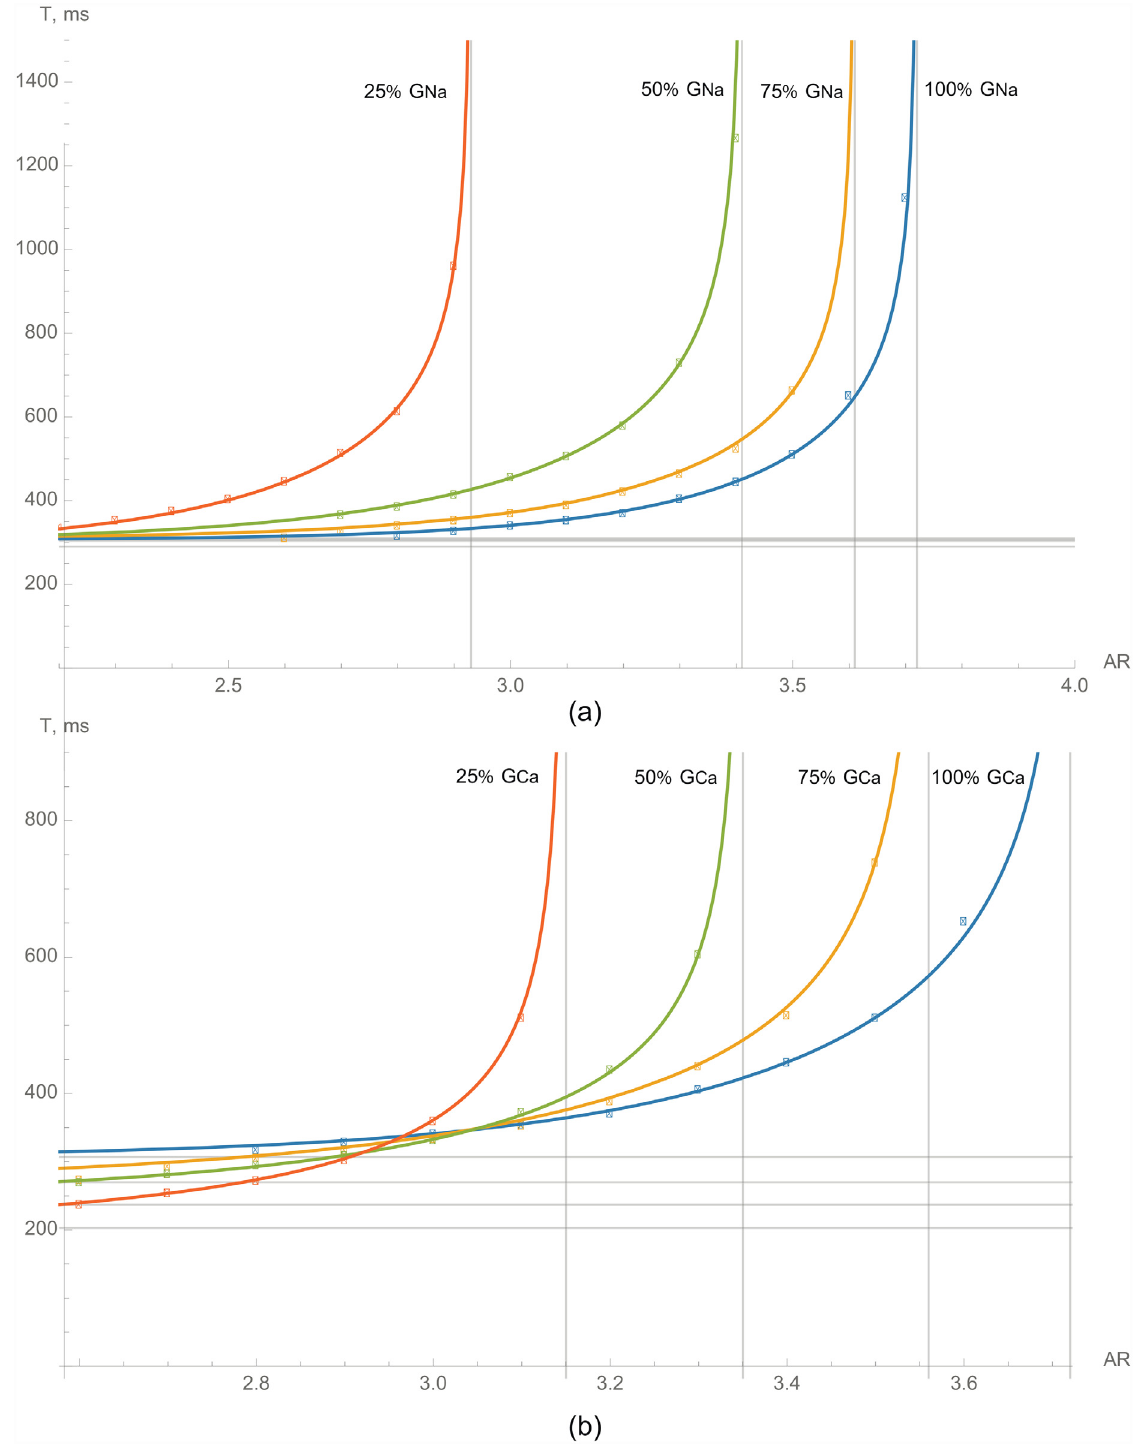
Fig 4. The dependencies of the critical period of stimulation on the AR for normal cardiomyocytes (blue line), with the addition of various channel blockers. Inhibition of (a) — I Na , (b) — I Ca .